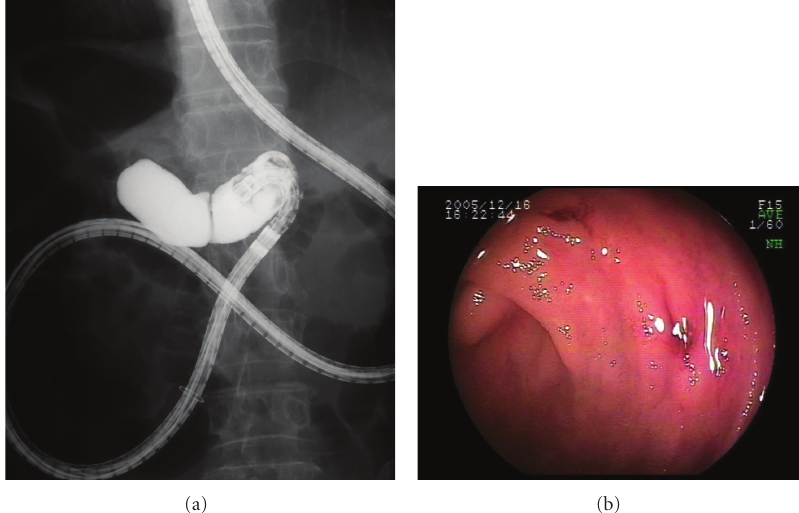
Figure 1: (a) Confirmation that the blind end was reached using fluoroscopy; (b) mucosal atrophy and angioectasias were found in the blind end.